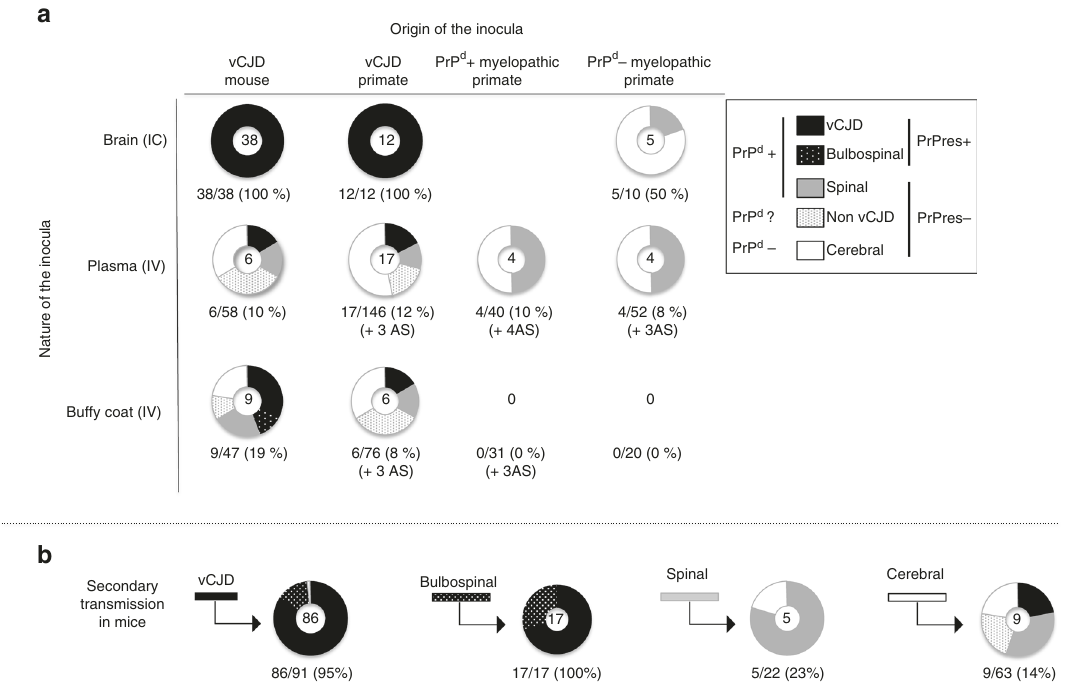
Fig. 7 Transmission in mice. The pattern of distribution of disease pro fi les depending on inocula a after exposure to crude brain, plasma or buffy coat derived from vCJD-infected mice or primates or (PrP d negative or PrP d positive) myelopathic primates, or b after exposure to SNC or spleen samples derived from mice exhibiting complete or incomplete vCJD phenotypes (secondary transmission). For each inoculum, the pattern of disease pro fi les observed in affected mice (numbers at the centre of each circle) is depicted in fi ve categories grouped according to their status towards abnormal PrP: classical vCJD pattern (protease-resistant PrP d , black), bulbospinal (BS) pattern (protease-resistant PrP d , white-spotted black), spinal (S) pro fi le (protease- sensitive PrP d , grey) or cerebral involvement grouping cerebral (C), bulbar (B) pro fi les and animals with only neuronal lesions (NL) (no detectable PrP d , white). The fi fth category (grey-spotted white) corresponds to the non-vCJD mice (affected mice devoid of PrP res but not sampled for histology. They might present either a spinal pro fi le or cerebral involvement). Below each circular panel are speci fi ed the percentage of transmission and the numbers of aging spinal animals